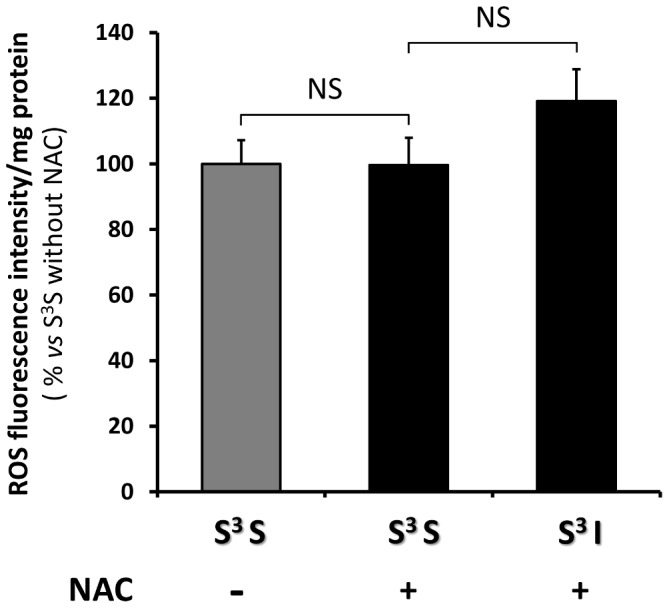
NAC treatment prevents hypoglycemia-induced increased VMH ROS production.Quantification of VMH fluorescence intensity of the ROS sensitive probe H2DCFDA of rats injected SC with saline or insulin (4 U/kg) and treated or not with NAC (5 g/l) in their drinking water. Data are expressed as % of control rats not treated with NAC and injected with saline (S3S). n number: S3S: n = 16; S3S + NAC: n = 8; S3I + NAC: n = 8. NS: p>0.05 (One-way ANOVA).